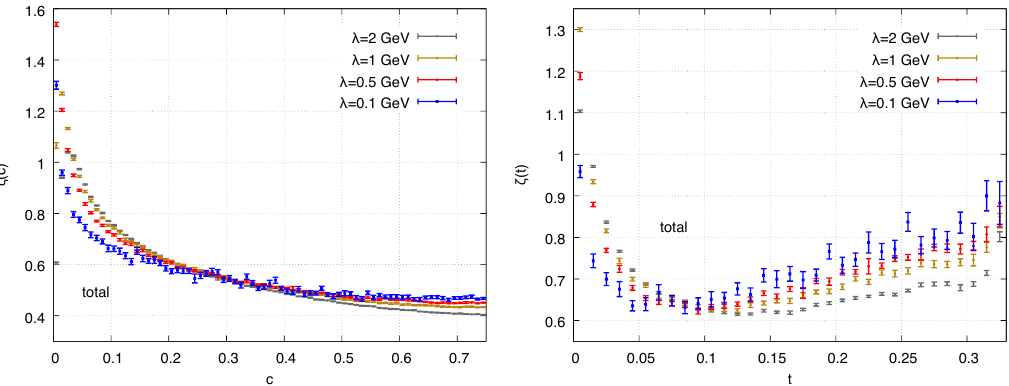
Figure 6 . The functions ζ ( c ) and ζ ( t ) for the C -parameter and for thrust t = 1 − T , obtained using Q = 100 GeV and λ = 2 GeV, λ = 1 GeV, λ = 0 . 5 GeV and λ = 0 . 1 GeV. See text for